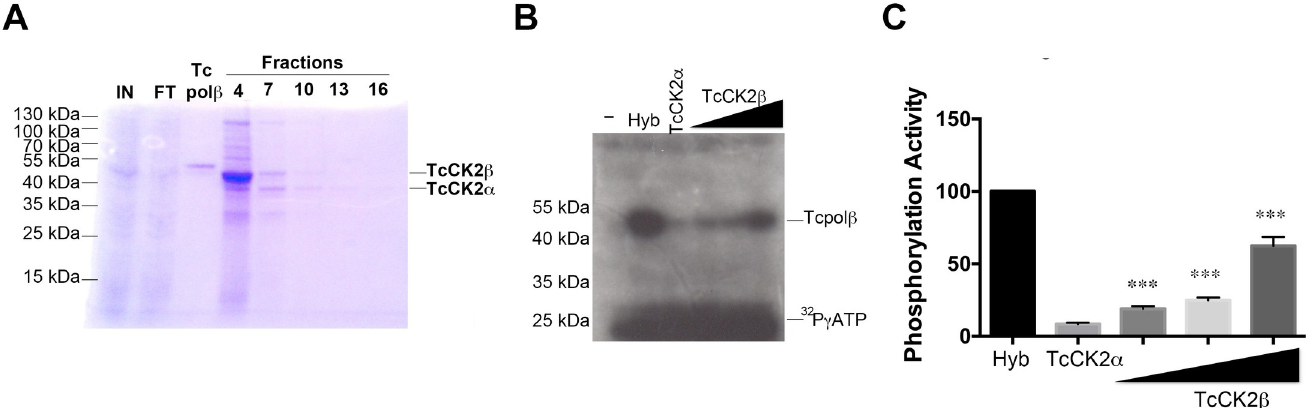
Fig 3. TcCK2 is able to phosphorylate Tcpol β . A) Purification of TcCK2 holoenzyme and analysis by SDS-PAGE. Crude fractions of TcCK2 α and TcCK2 β were mixed and purified through NTA-Ni-Agarose as described in Materials and Methods. The gel shows the Tcpol β substrate and the fractions eluted from the column. Fraction number 7 was used in the initial attempts to phosphorylate casein, however, those experiments failed. IN: input and FT: material that did not bind to the resin. B) TcCK2 β can stimulate the activity of TcCK2 α . In this experiment it can be observed that TcCK2 α does not get auto-phosphorylated (-). Hybrid CK2 (Hyb) is able to phosphorylate Tcpol β substrate and TcCK2 α by itself can phosphorylate Tcpol β at low levels, however, it is stimulated by TcCK2 β , although at lower levels than pCK2 β . In this experiment, 20 pmol of TcCK2 α was used in each experiment with increasing amounts (8, 16 and 32 pmol) of TcCK2 β as indicated in the figure. The heavy band on the bottom of film and labeled 32P γ ATP is free nucleotide that did not run out of the gel and covers phosphorylation of pCK2 β . (-) indicates Tcpol β substrate alone. C) Plot that shows the stimulation levels of TcCK2 β on TcCK2 α to phosphorylate Tcpol β . Results are expressed in arbitrary units and represent the mean +/- SD of three independent experiments. Significance is defined as p < 0.05 when the mean of the experiments is compared with hybrid enzyme. ��� indicates p < 0.001.